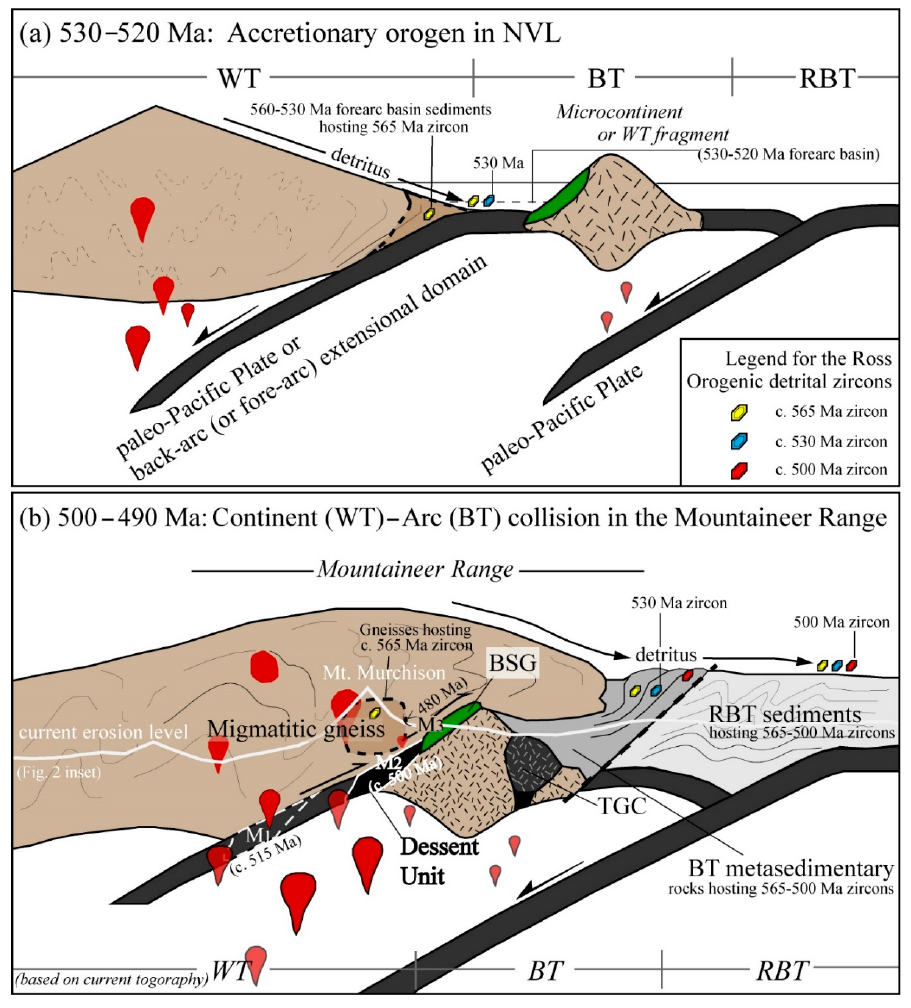
Figure 14. The tectonic model for the Ross Orogeny in the Mountaineer Range. ( a ) Accretionary orogeny (530–520 Ma) and syn-orogenic deposition of arc-derived detritus: there exist two parallel subduction zones and early Cambrian magmatism comparable with plutons in the WT interior (e.g., [15,31,49–51]). ( b ) Continent (WT)–arc (BT) collision, magmatism and migmatization (peak at c.